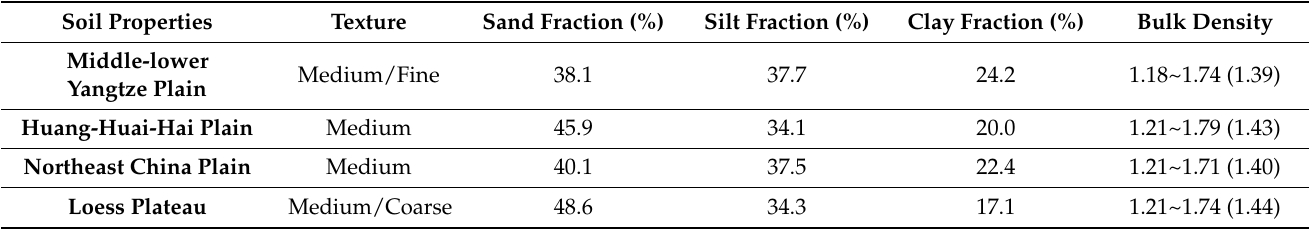
Table 1. Key physical soil properties for topsoil (0–30 cm) in four agricultural zoning areas. (Note that only three simplified textural classes were used: Coarse-, Medium-, and Fine-textured, due to the scale (1:5 million) of the Soil Map of the World, and that numbers in the brackets of the last column indicate the average value of bulk